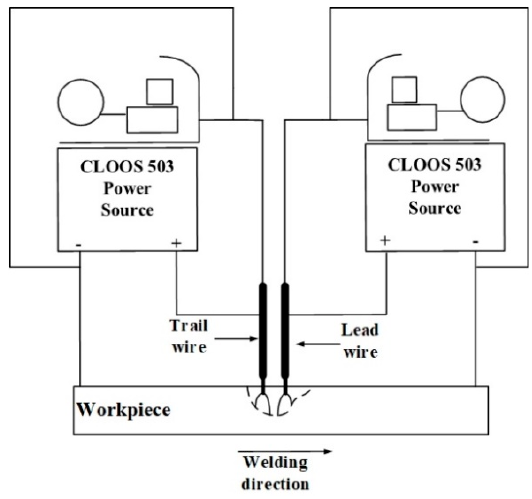
Figure 1. Experimental apparatus.